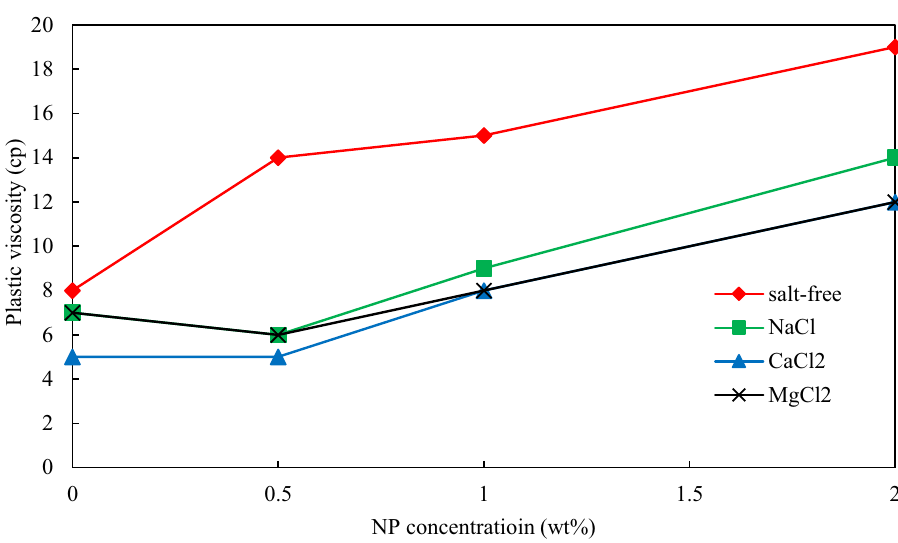
Fig. 3 Plastic viscosity of salt- free and salty drilling fluids